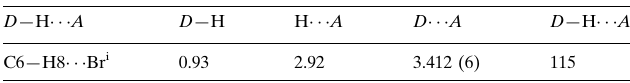
Hydrogen-bond geometry (A˚ , (cid:4)